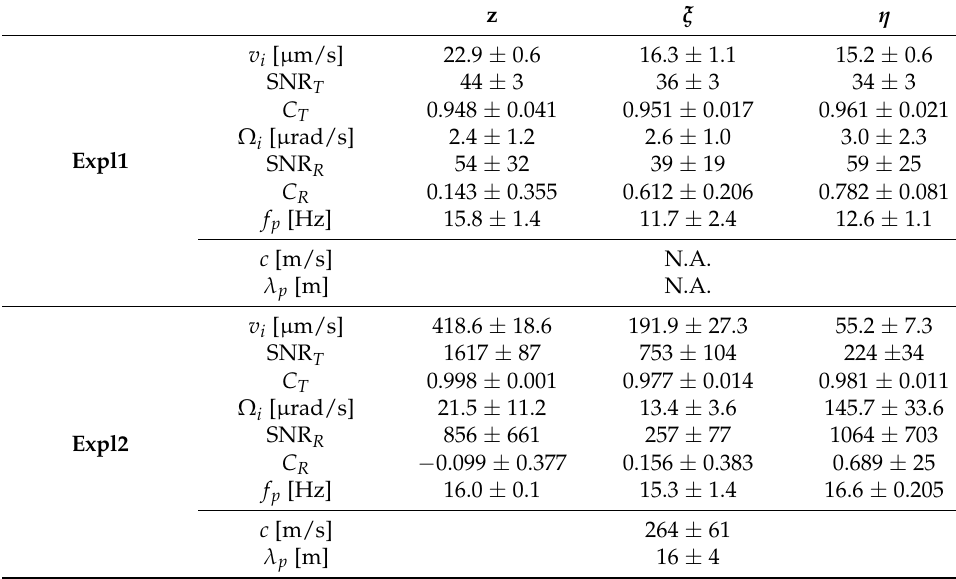
Table 3. Huddle-test active-source Rotaphone measurements by component ( z —vertical, ξ —radial, η —transverse): means over all Rotaphones ± standard deviation. Key: v i and Ω i , i = z , ξ , η , are maximum absolute values of translational and rotational components, respectively; SNR T and SNR R are signal-to-noise ratios in translational and rotational components, calculated from noise in time interval between − 10 s and − 2 s prior the first onset; C T or C R represent Pearson correlation coefficients between translational or rotational records from each two Rotaphones; f p means the prevailing frequency, calculated as instantaneous frequency of maximum rotation rate; c denotes apparent phase velocity calculated as the a z / Ω η ratio at the Ω η maximum; λ p is the estimate of the prevailing apparent wavelength (along the Earth’s surface) calculated whiel using a z / Ω η ratios and f p , both for maximum Ω η . z ξ